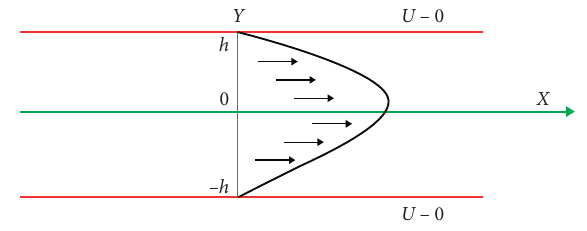
Figure 1: Geometrical